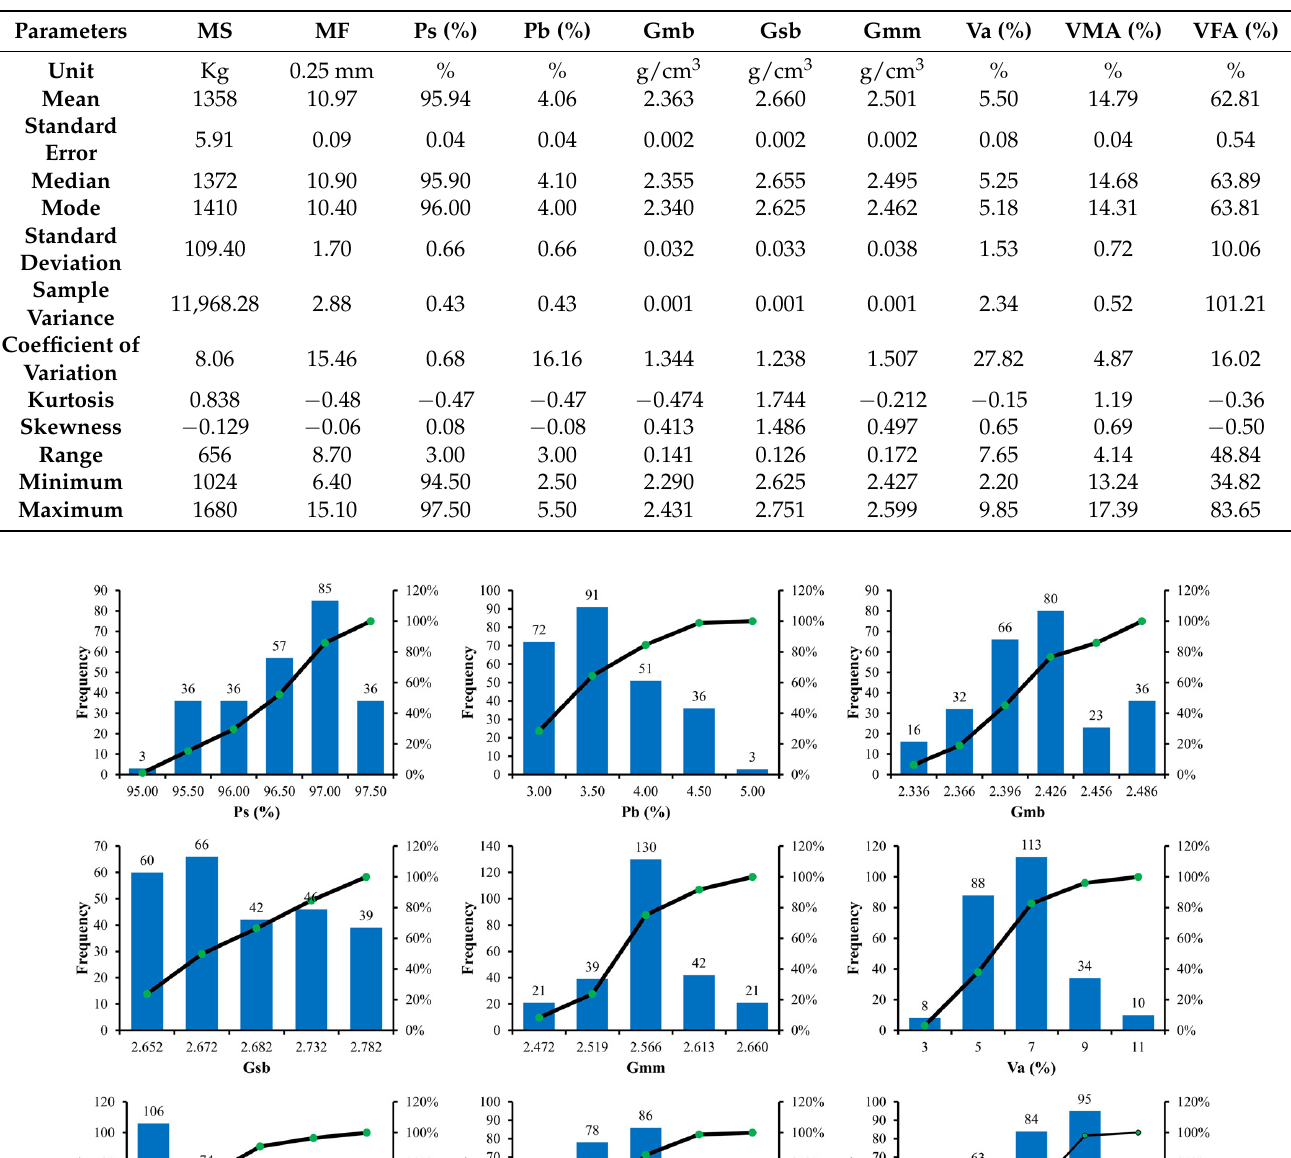
Table 4. Statistical range of input and output data of AWC.